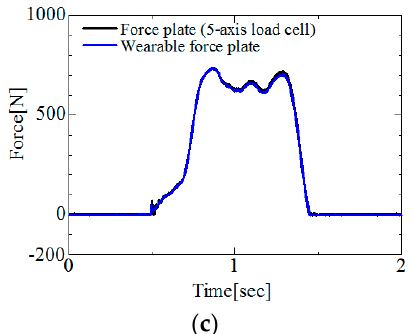
Figure 6. Results for force components on the force plate installed with 5-axis load cells and the wearable force plate; ( a ) F x (lateral direction) component; ( b ) F y (traveling direction) component; ( c ) F z (vertical direction)